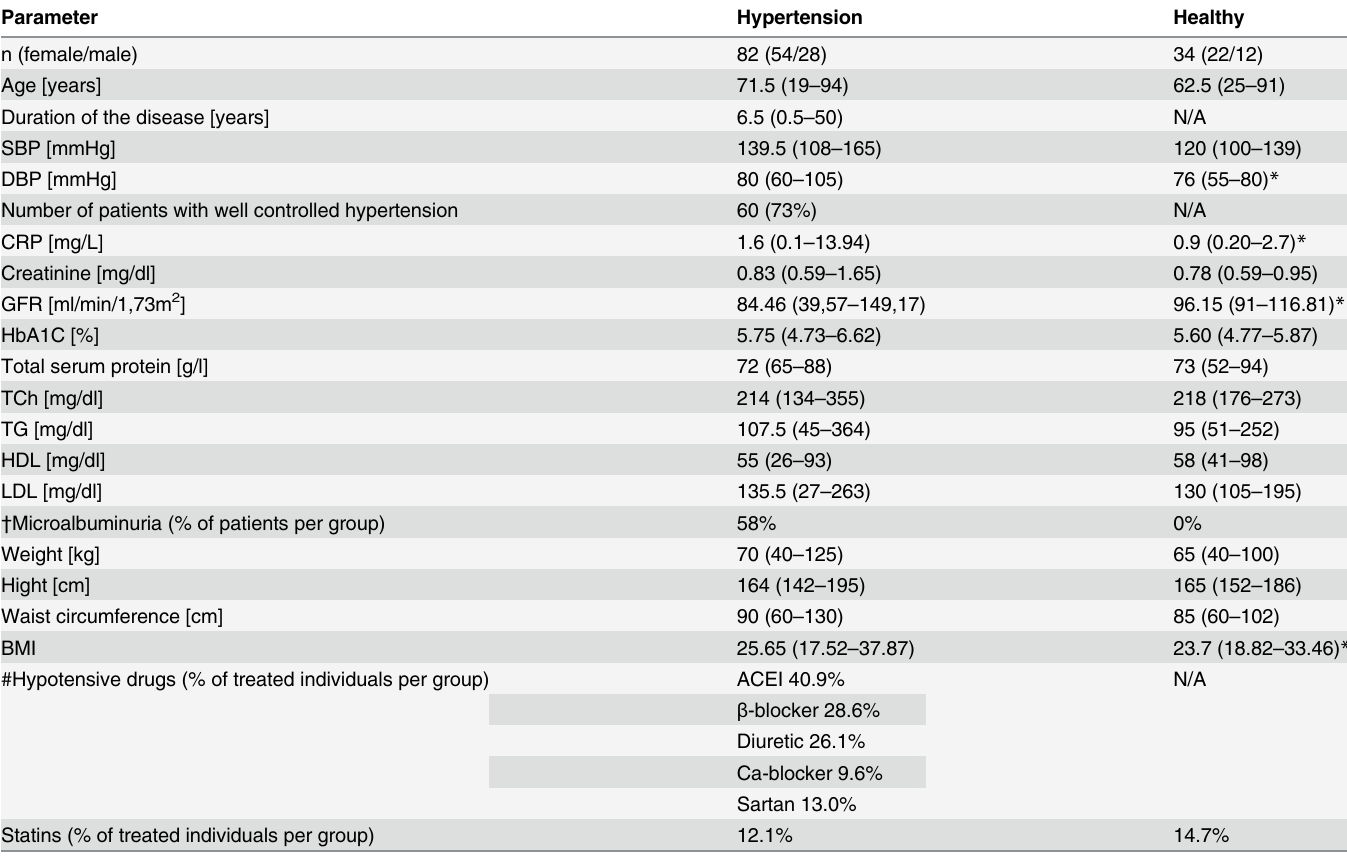
Table 1. Clinical and laboratory characteristics of the investigated